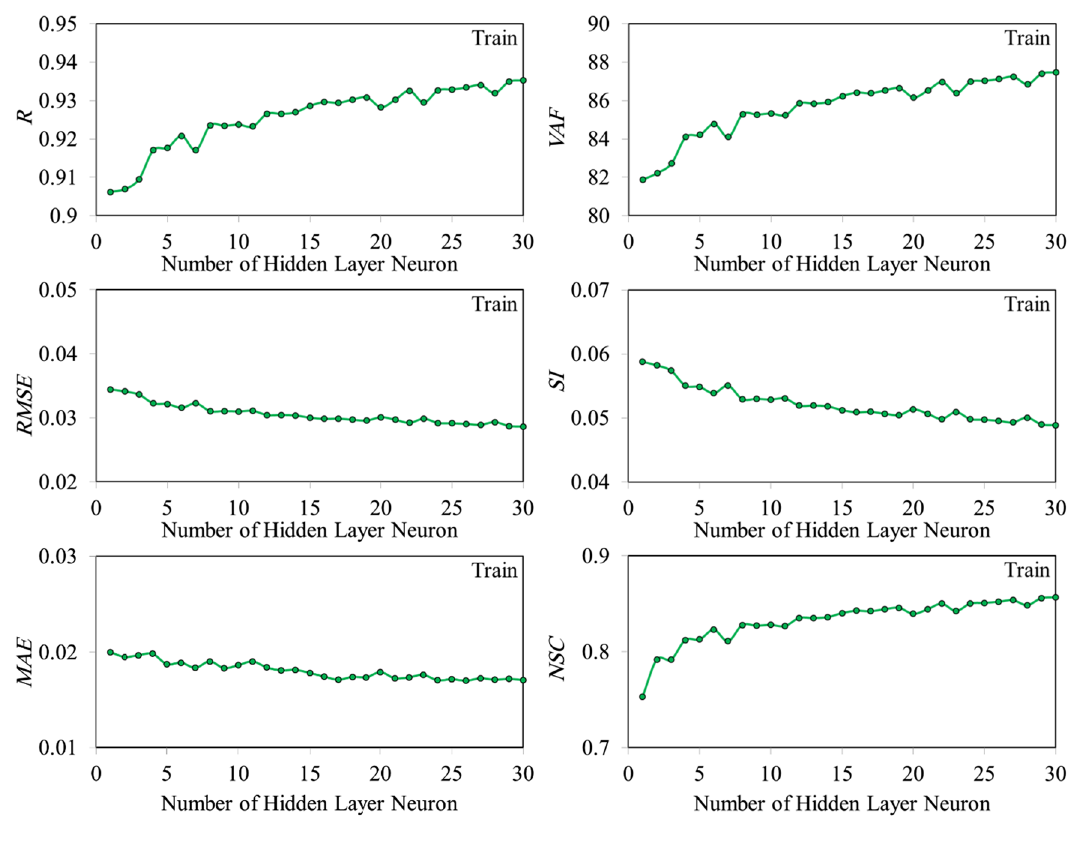
Fig. 3 Variations of NHLN versus different statistical indices in training